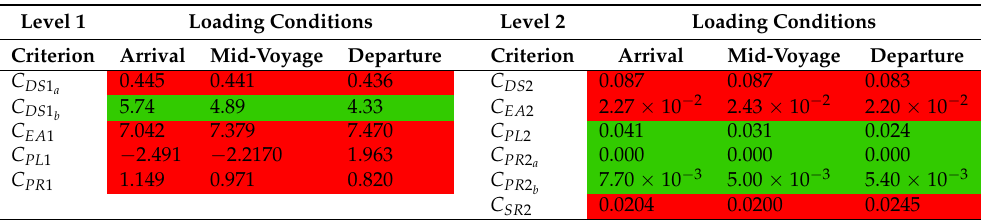
Table 12. Comprehensive assessment of SGISc vulnerability levels for Y03 considering the central Mediterranean Sea. Criteria compliant with the standard are highlighted in green. Criteria not compliant with the standard are highlighted in